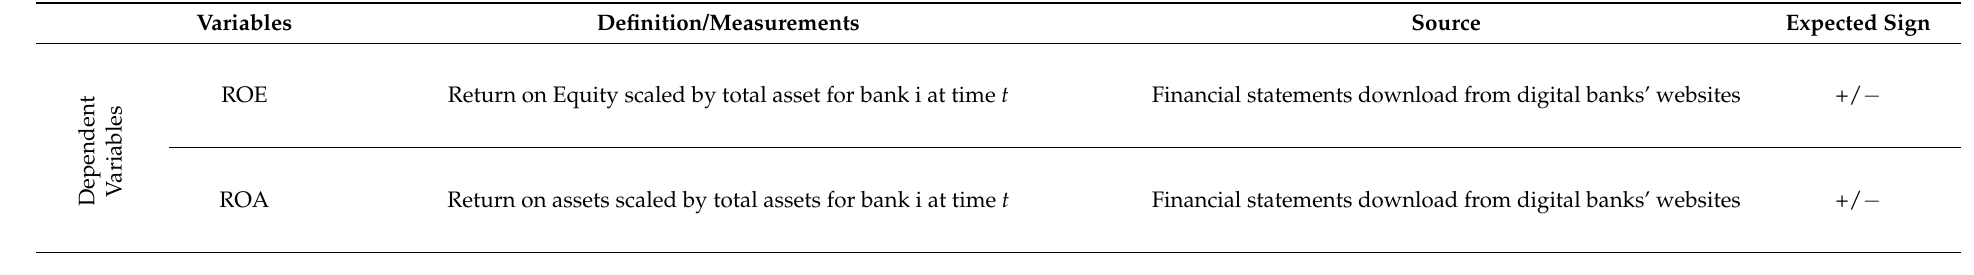
Table 1. Measurement of dependent and independent